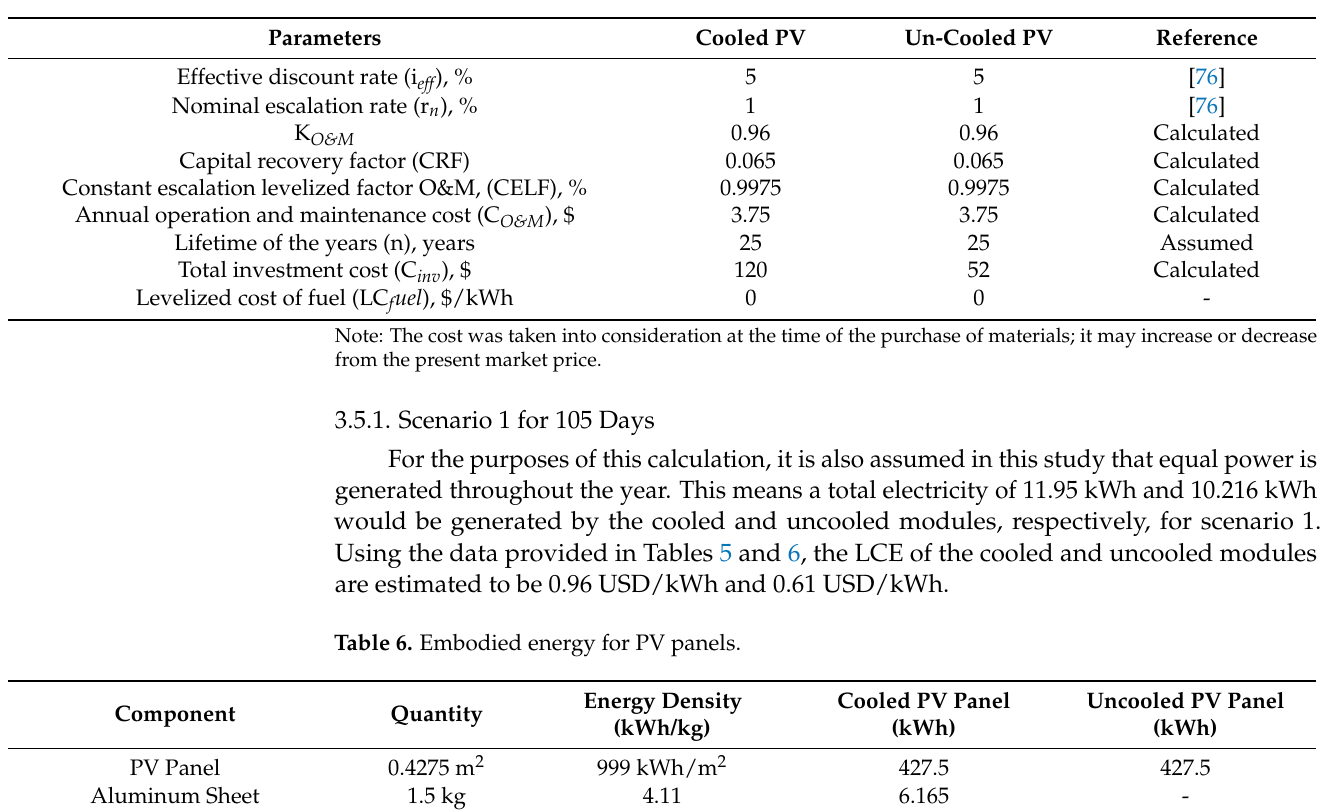
Table 5. Parameters used for LCE calculations.